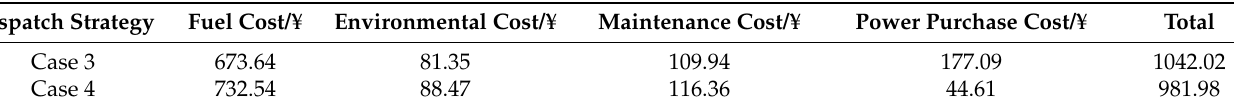
Table 6. Cost comparison of case 3 and case 4 in winter.